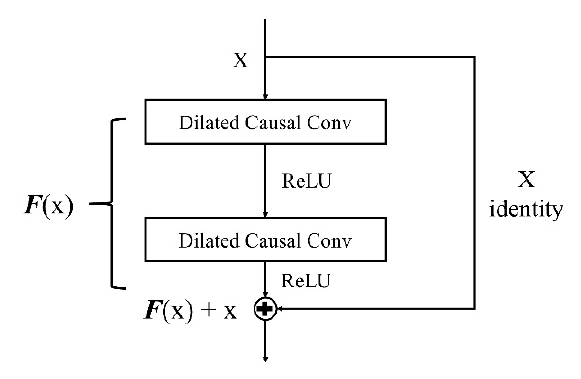
Figure 6. Residual Figure 6. Residual block.